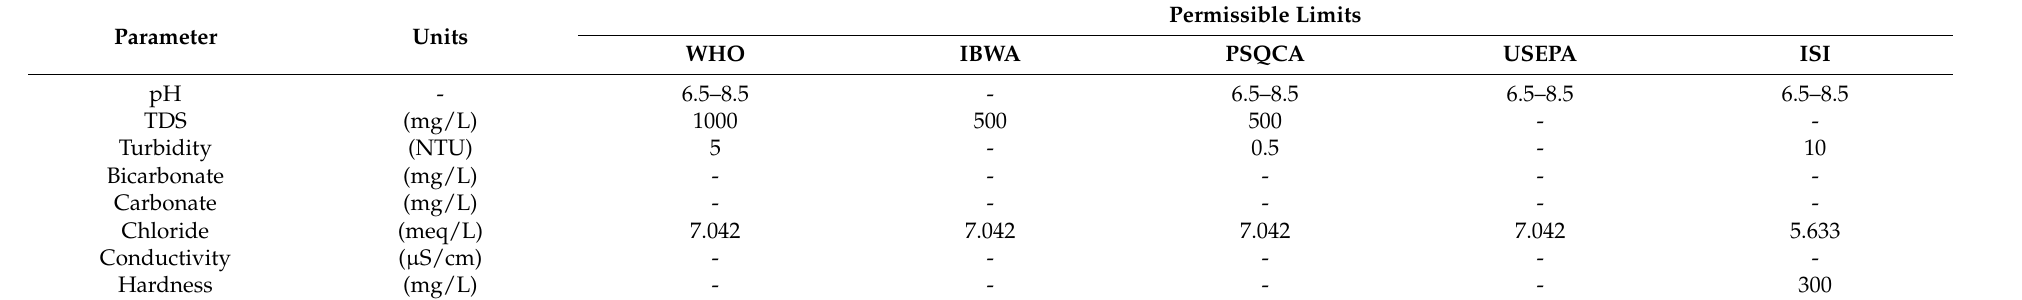
Table A2. Drinking water